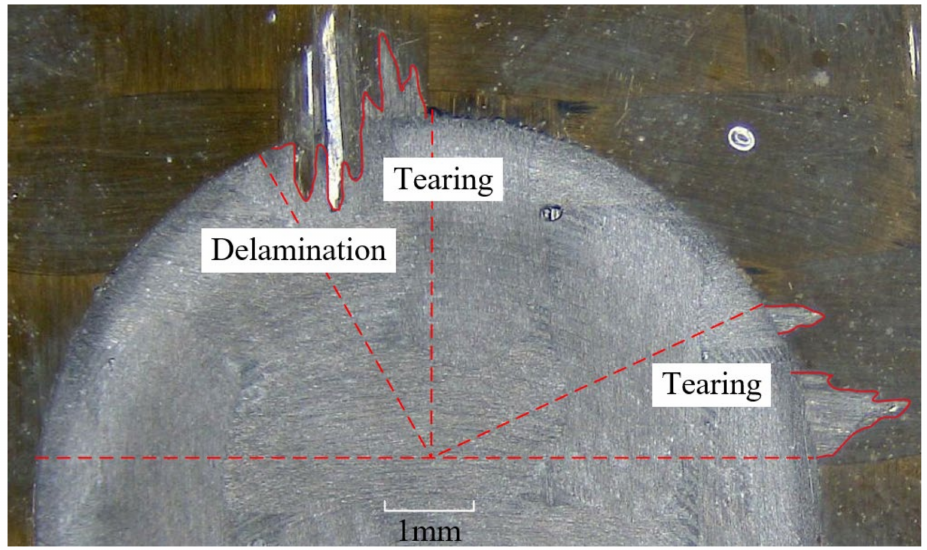
Figure 10. Delamination and tearing on top